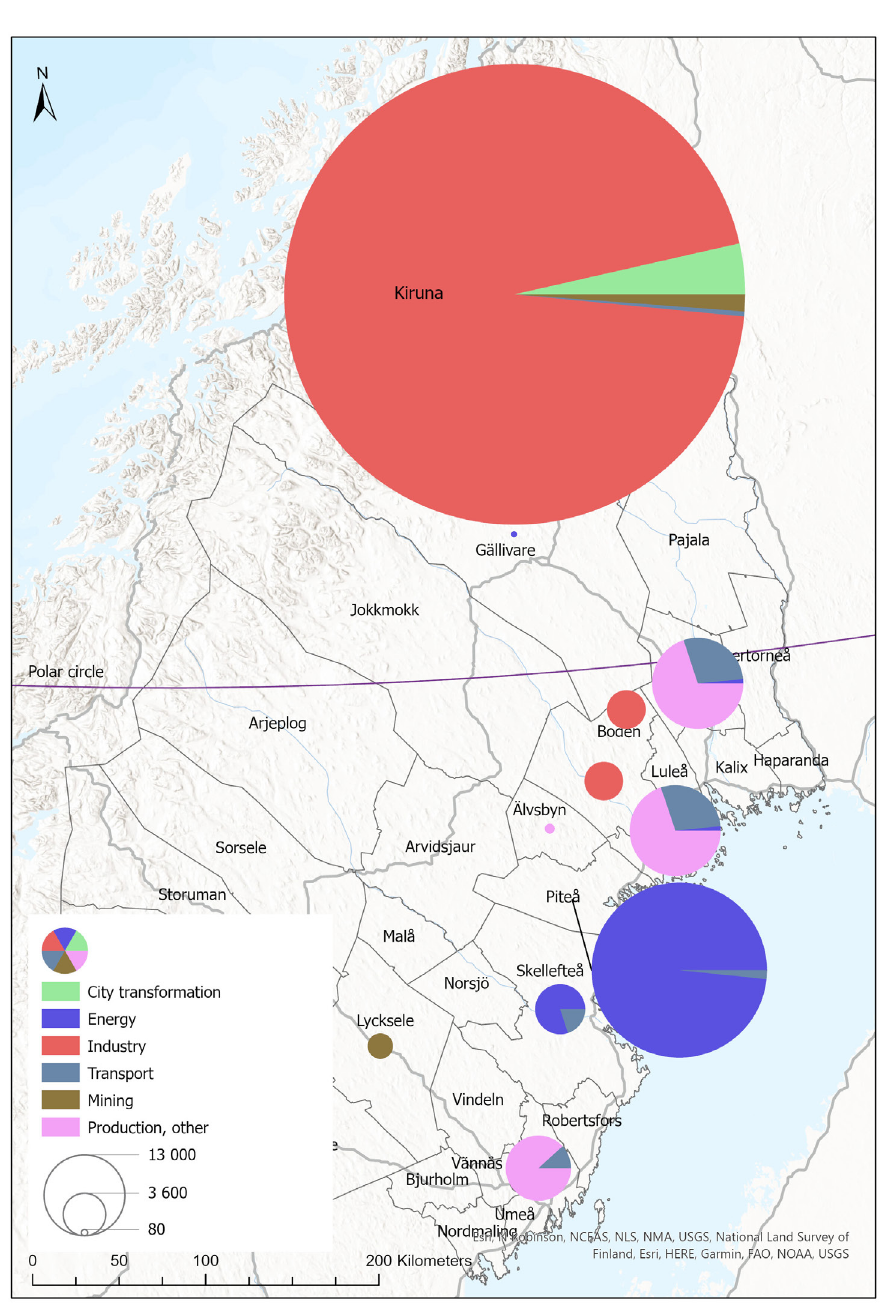
Fig 2. The investments in the study area by type, by sum (MSEK) and